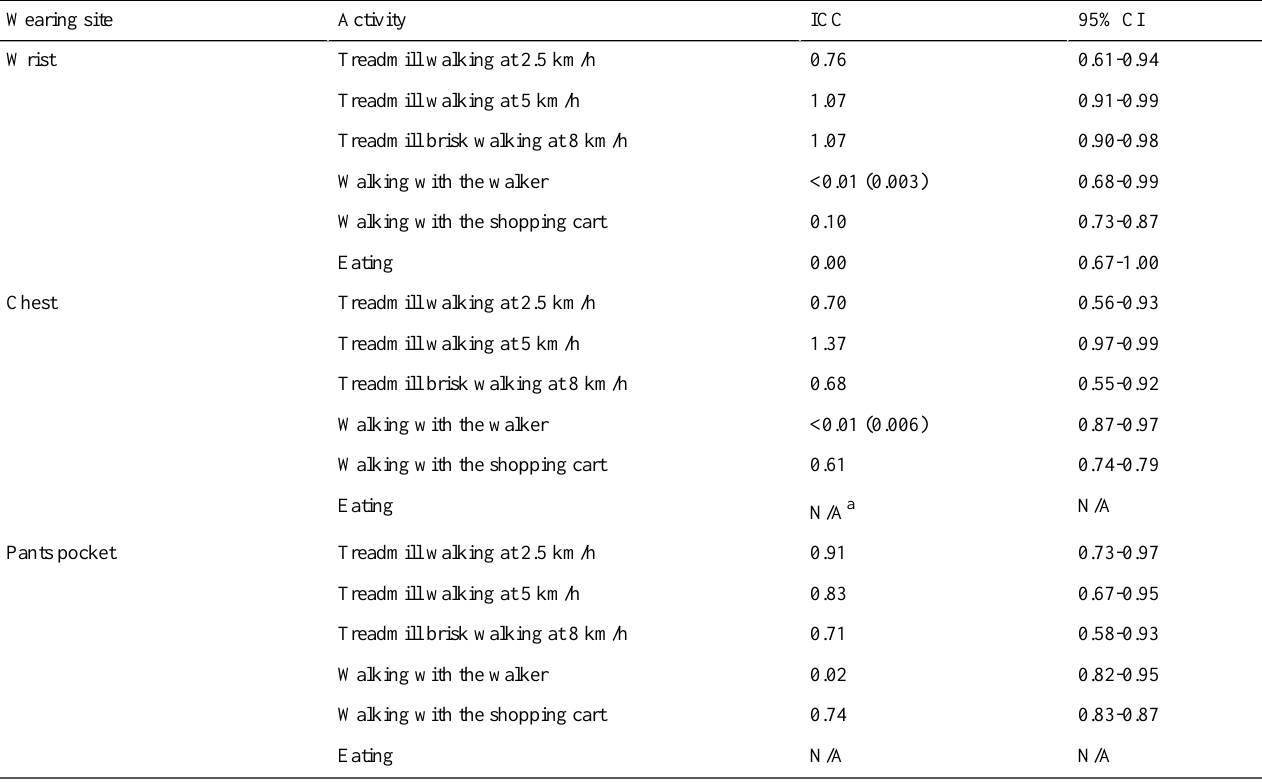
Table 4. Intraclass correlation coefficients between the wearing sites and gold standard